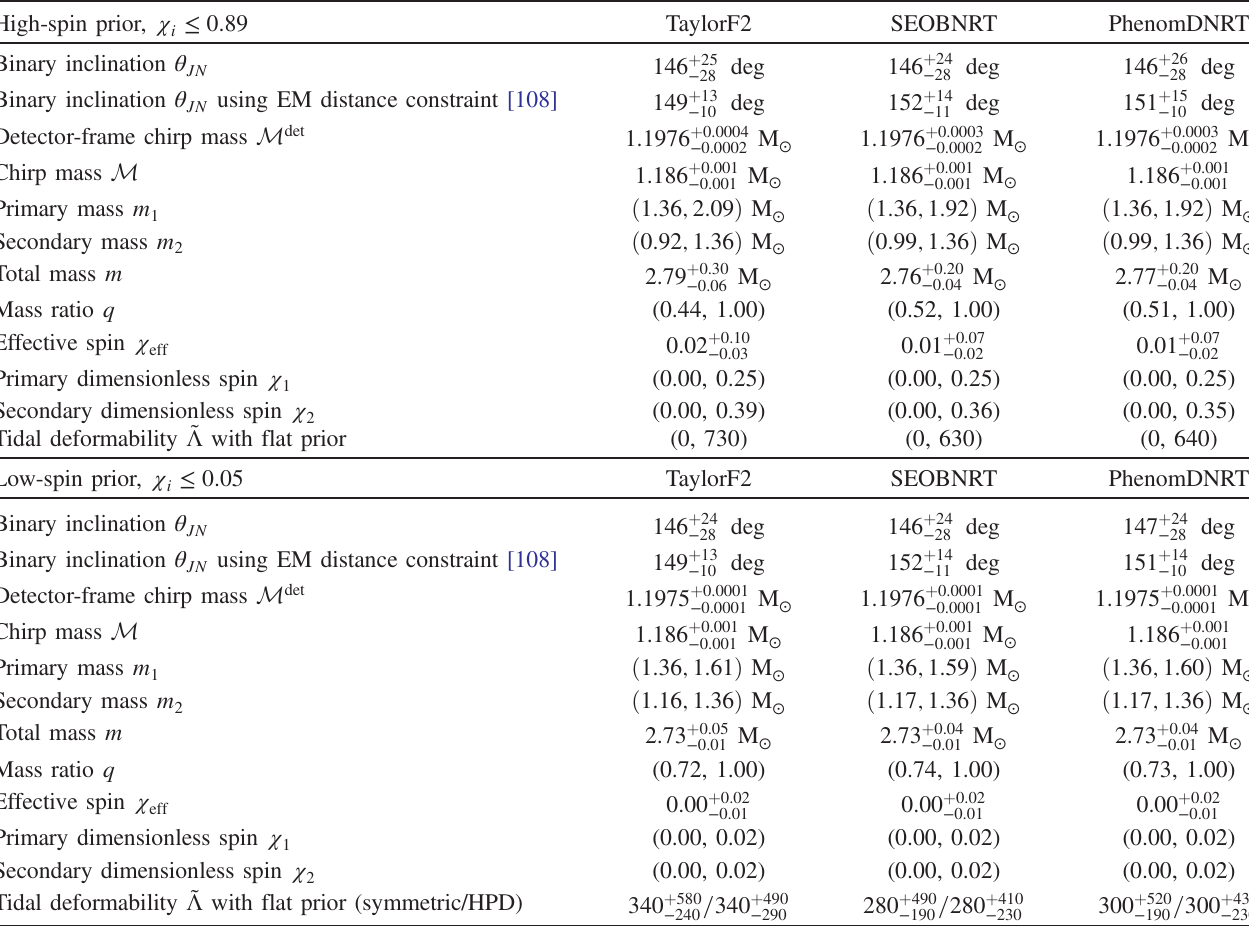
TABLE IV. Source properties for GW170817 using the additional waveform models TaylorF2, PhenomDNRT, and SEOBNRT. Conventions are the same as in Table II. The TaylorF2 results here can be directly compared with those from Ref. [3]. Note that the 90% ˜ Λ upper limits for reported in Table I of Ref. [3] for TaylorF2 are incorrect (see Sec. III D). In Ref. [3], for the high-spin prior, it should be ≤ 800 and not ≤ 700 , while for the low-spin prior, it should be ≤ 900 and not ≤ 800 . High-spin prior, χ i ≤ 0 . 89